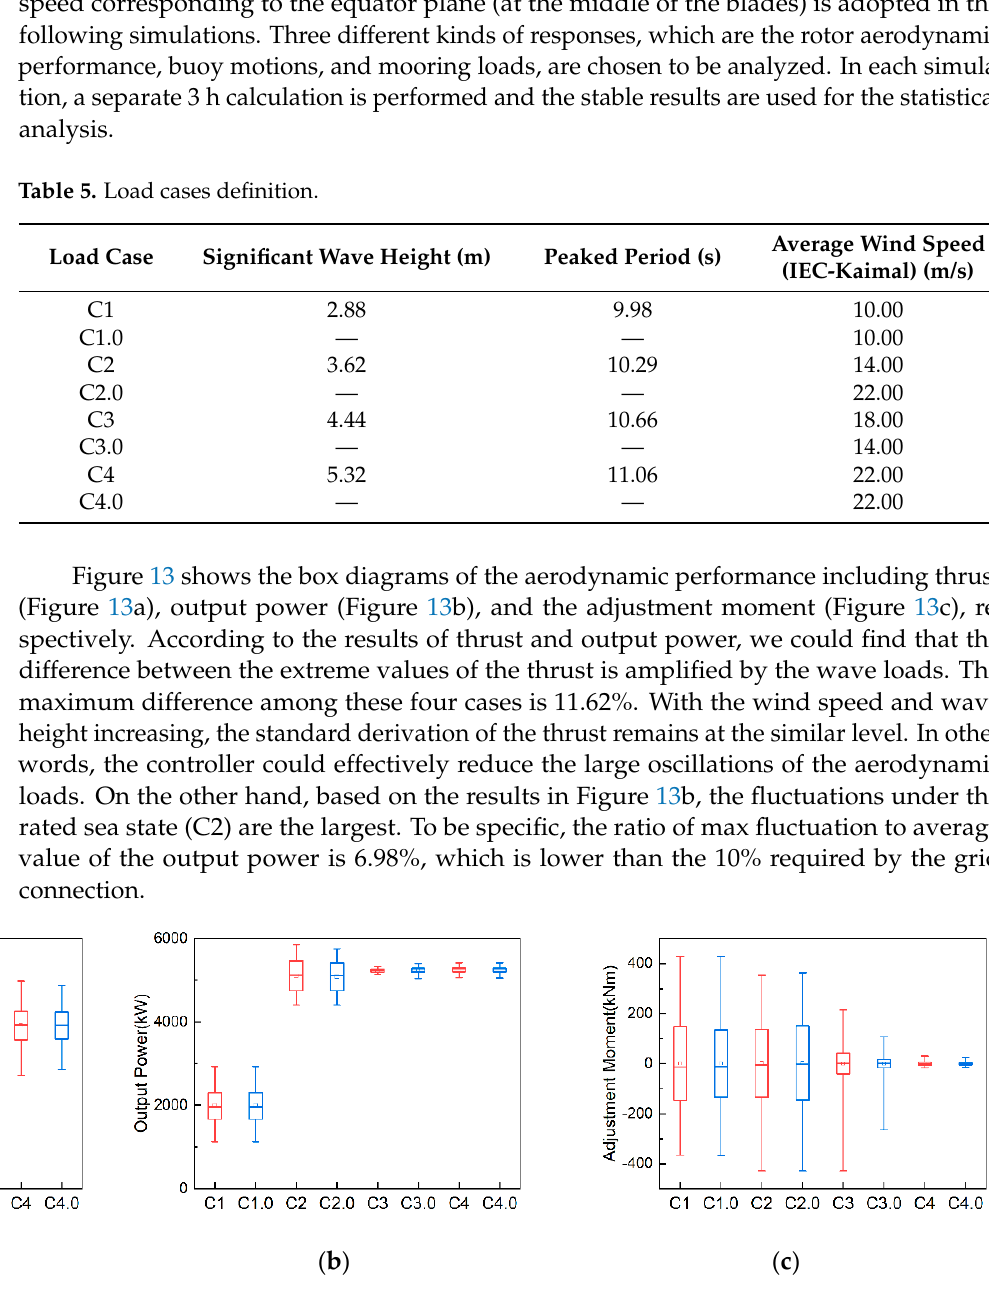
( b ) Figure 14. Buoy motion under different wind–wave sea scenarios. ( a ) Surge; ( b ) Yaw.